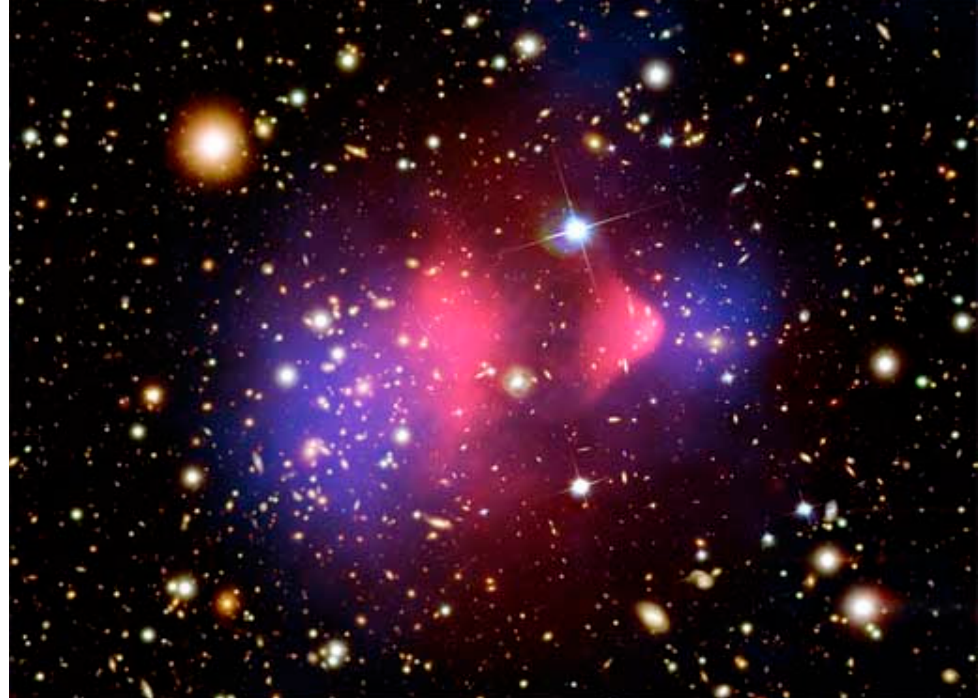
Figure 16. This composite image shows the galaxy cluster 1E 0657-56, also known as the “bullet cluster.” This cluster was formed after the collision of two large clusters of galaxies. Hot gas detected by Chandra in X-rays is seen as two pink clumps in the image and contains most of the “normal,” or baryonic, matter in the two clusters. The bullet-shaped clump on the right is the hot gas from one cluster, which was shocked in the collision but eventually passed through the hot gas from the other larger cluster during the collision. An optical image from Magellan and the Hubble Space Telescope shows the galaxies in orange and white. The blue areas in this image show where astronomers find most of the mass in the clusters via gravitational lensing. Most of the matter in the clusters (blue) is clearly separate from the normal matter (pink), giving direct evidence that nearly all of the matter in the clusters is dark. Image credit: X-ray: NASA/CXC/CfA/M.Markevitch et al.; Optical: NASA/STScI; Magellan/U.Arizona/D.Clowe et al.; Lensing Map: NASA/STScI; ESO WFI; Magellan/U.Arizona/ D.Clowe et al.